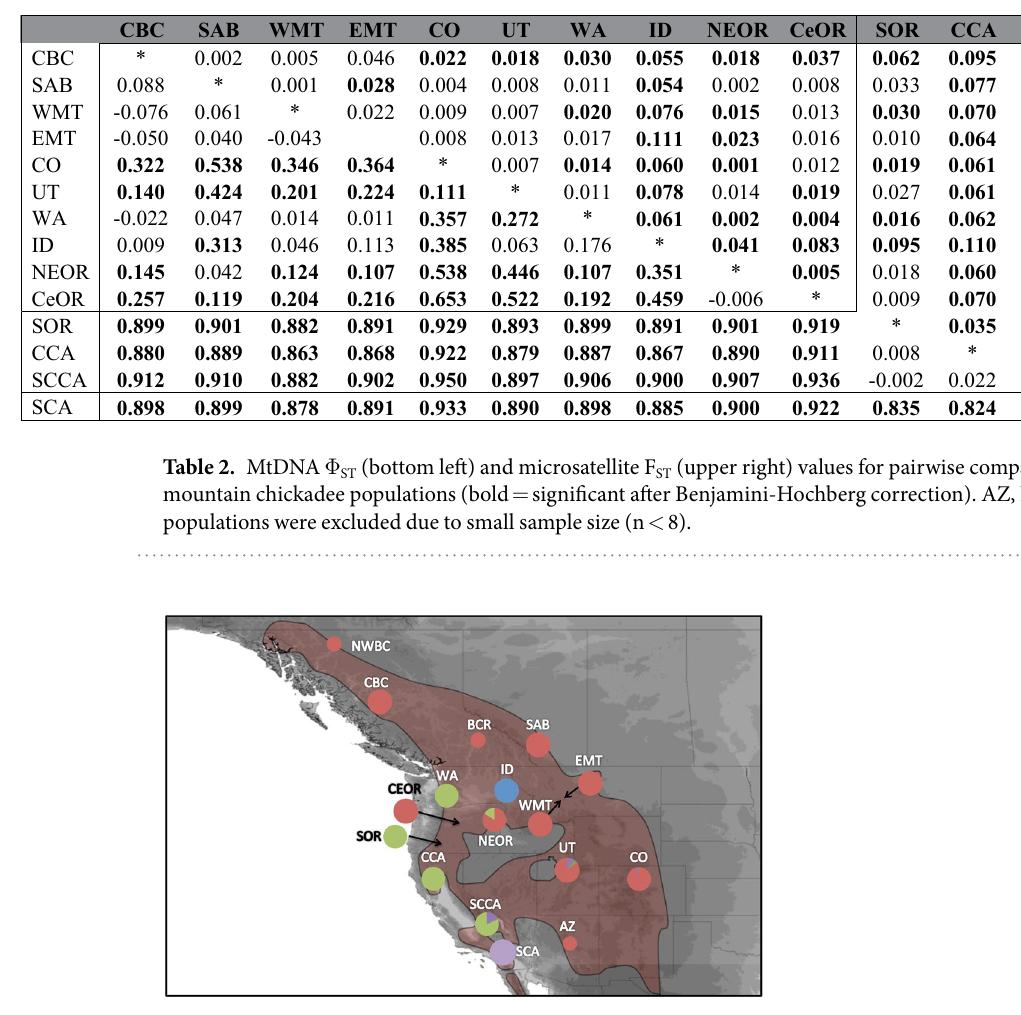
Figure 4. Proportion of individuals in each mountain chickadee population assigned to one of the four clusters by Structure based on microsatellite data. Individual birds were assigned to the cluster (each cluster indicated by different colour) with the highest Q value (ancestry coefficient). Populations with small circles represent sites where < 8 individuals were genotyped, and larger circles represent sites where ≥ 8 individuals were screened. Range maps were created in DIVA-GIS 7.5 (www.diva-gis.org) using digital distribution files provided by Ridgley et al . 70 .